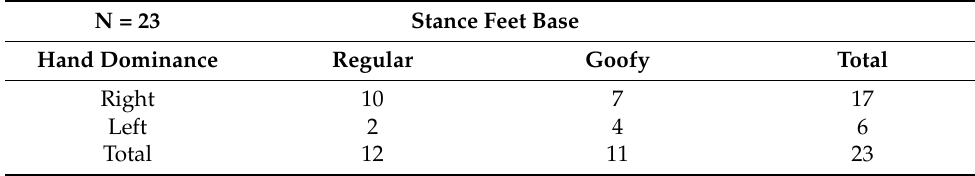
Table 1. Cross-information among the surfers’ hand dominance and stance feet base. N = 23 Stance Feet Base Hand Dominance Regular